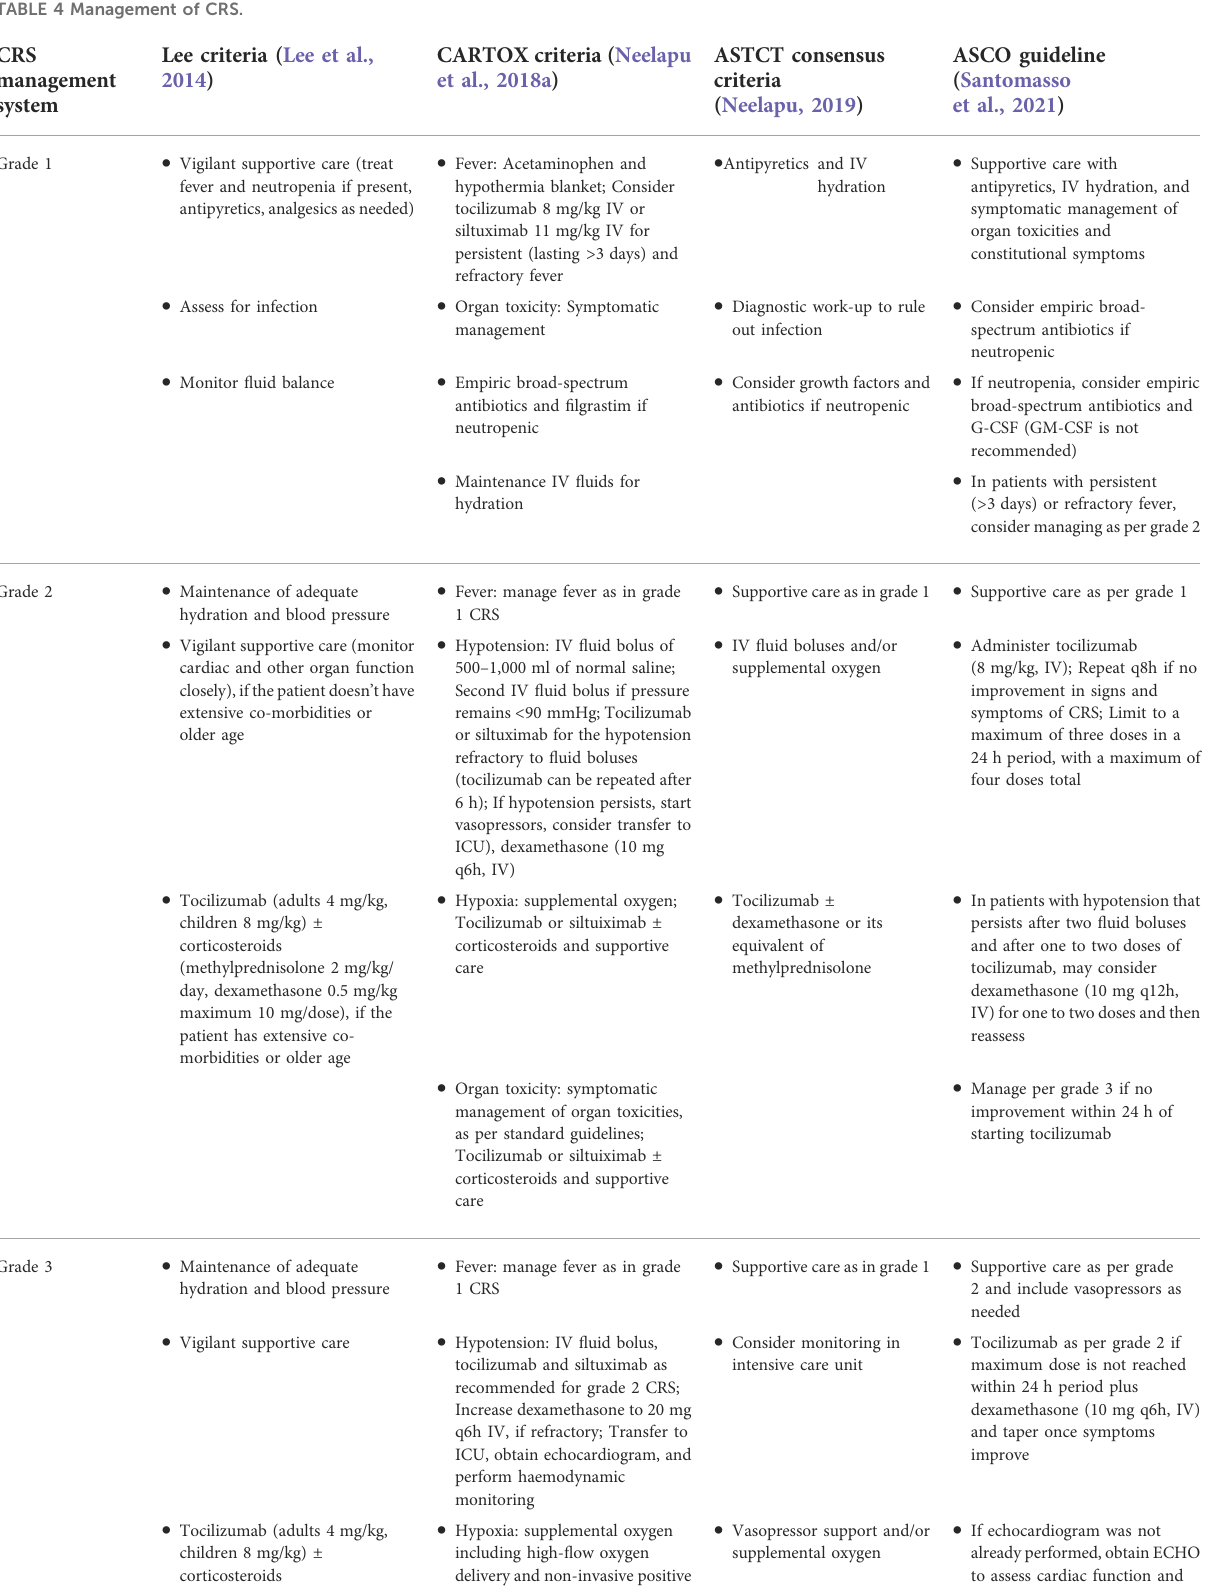
TABLE 4 Management of